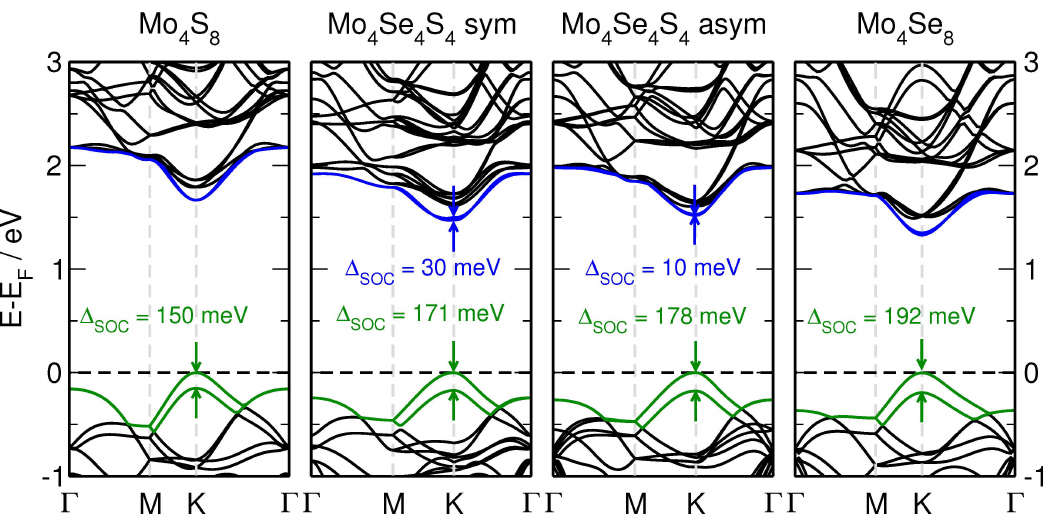
Figure 11. Calculated band structures of MoS 2 , MoSe 2 , and MoSeS systems with spin-orbit coupling ( ∆ SOC